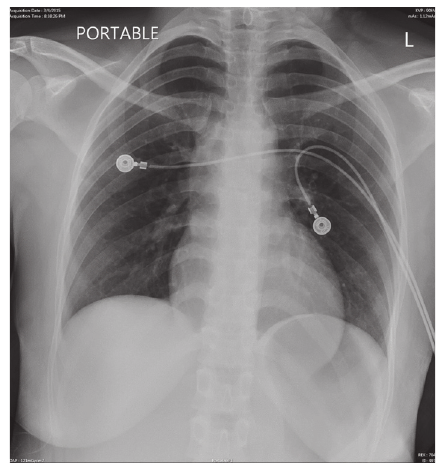
Figure 4: Transthoracic